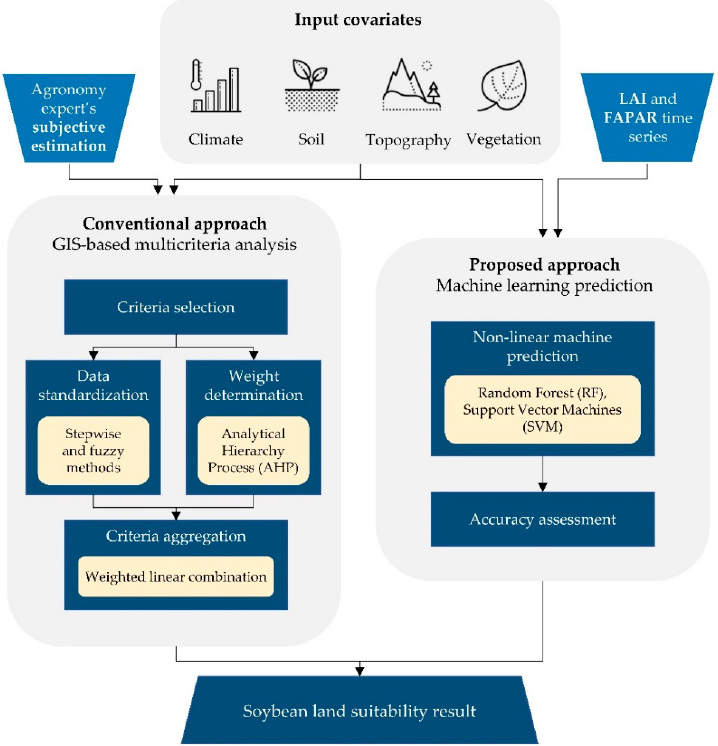
Figure 1. Major components of the conventional and proposed cropland suitability determination methods.